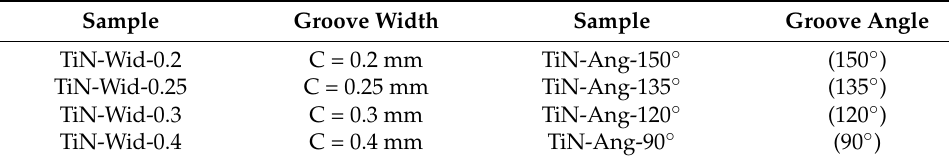
Table 2. Compositions of TiN coating.